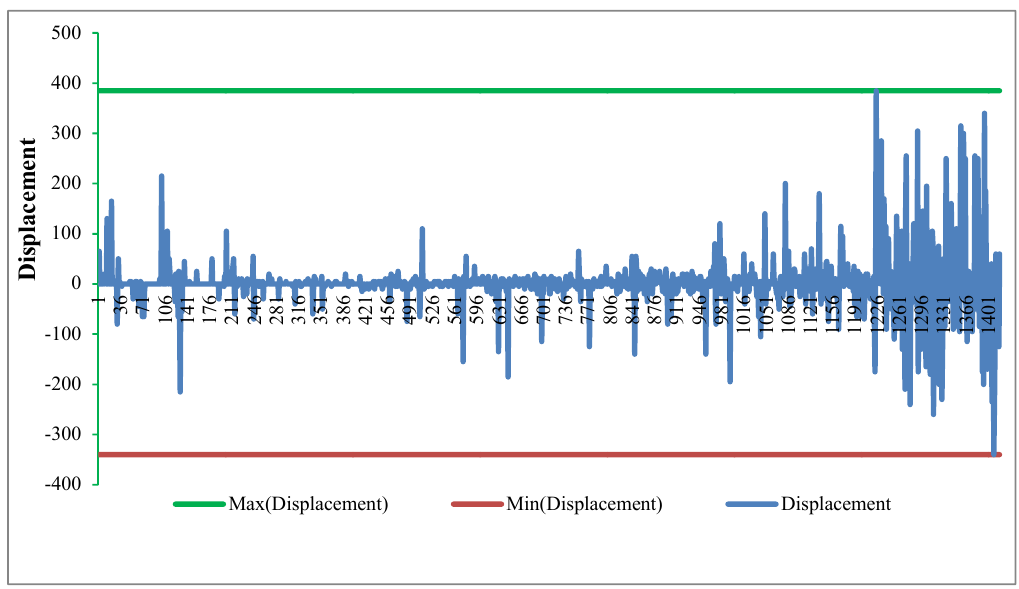
Figure 5. Displacement of required slot while objective function not including difficulty cost.